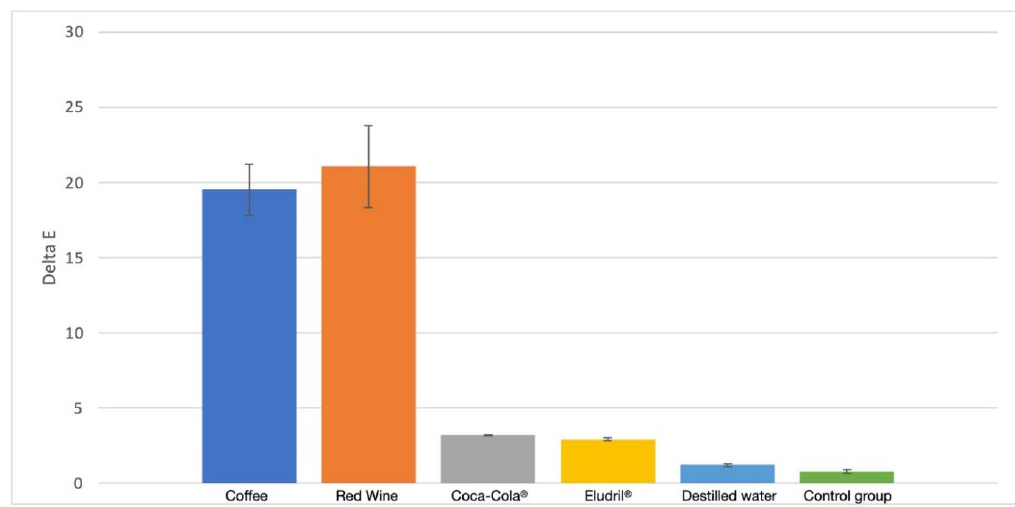
Figure 4. Comparison of the chromatic difference (ΔE) between the different solutions. Table 2. Mean ± standard deviation values of ΔE parameters after immersing the specimens in the following solutions for 40 h: coffee, red wine, Eludril TM , Coca-Cola TM and distilled water.